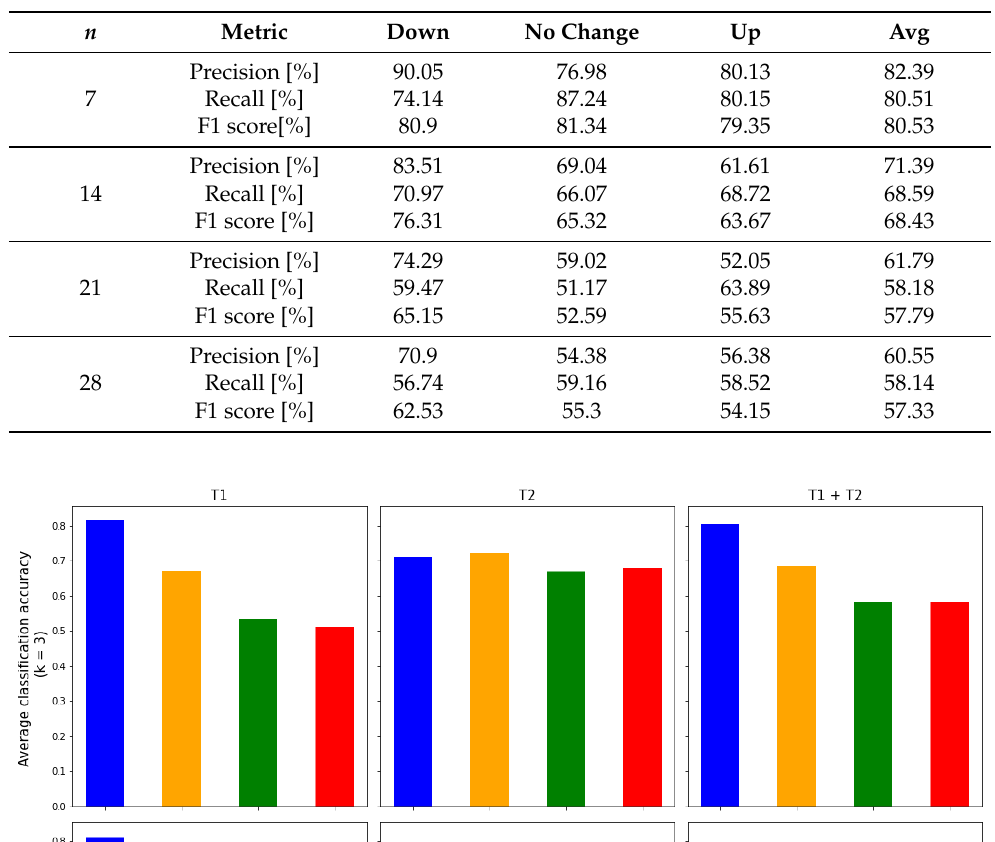
Table 4. Classification results for data from both tour operators and series length 3.